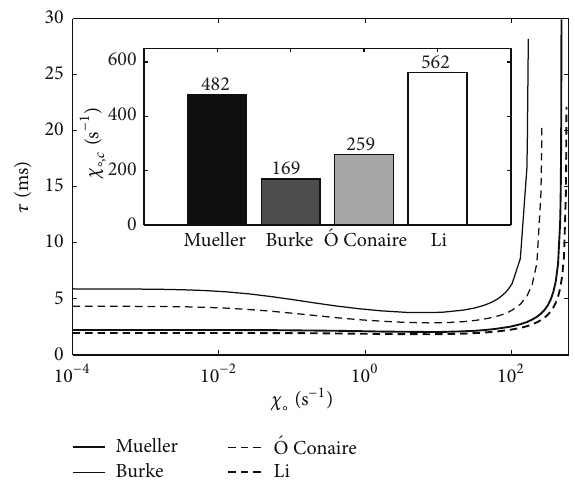
Figure 13: Ignition delay as a function of the peak scalar dissipation rate 𝜒 ∘ obtained using the mechanisms of Mueller et al. [53], ´O Conaire et al. [43], Li et al. [41], and Burke et al. [42] for 𝑇 𝑐 = 1045 K. The inset shows the critical values of 𝜒 ∘ above which ignition cannot